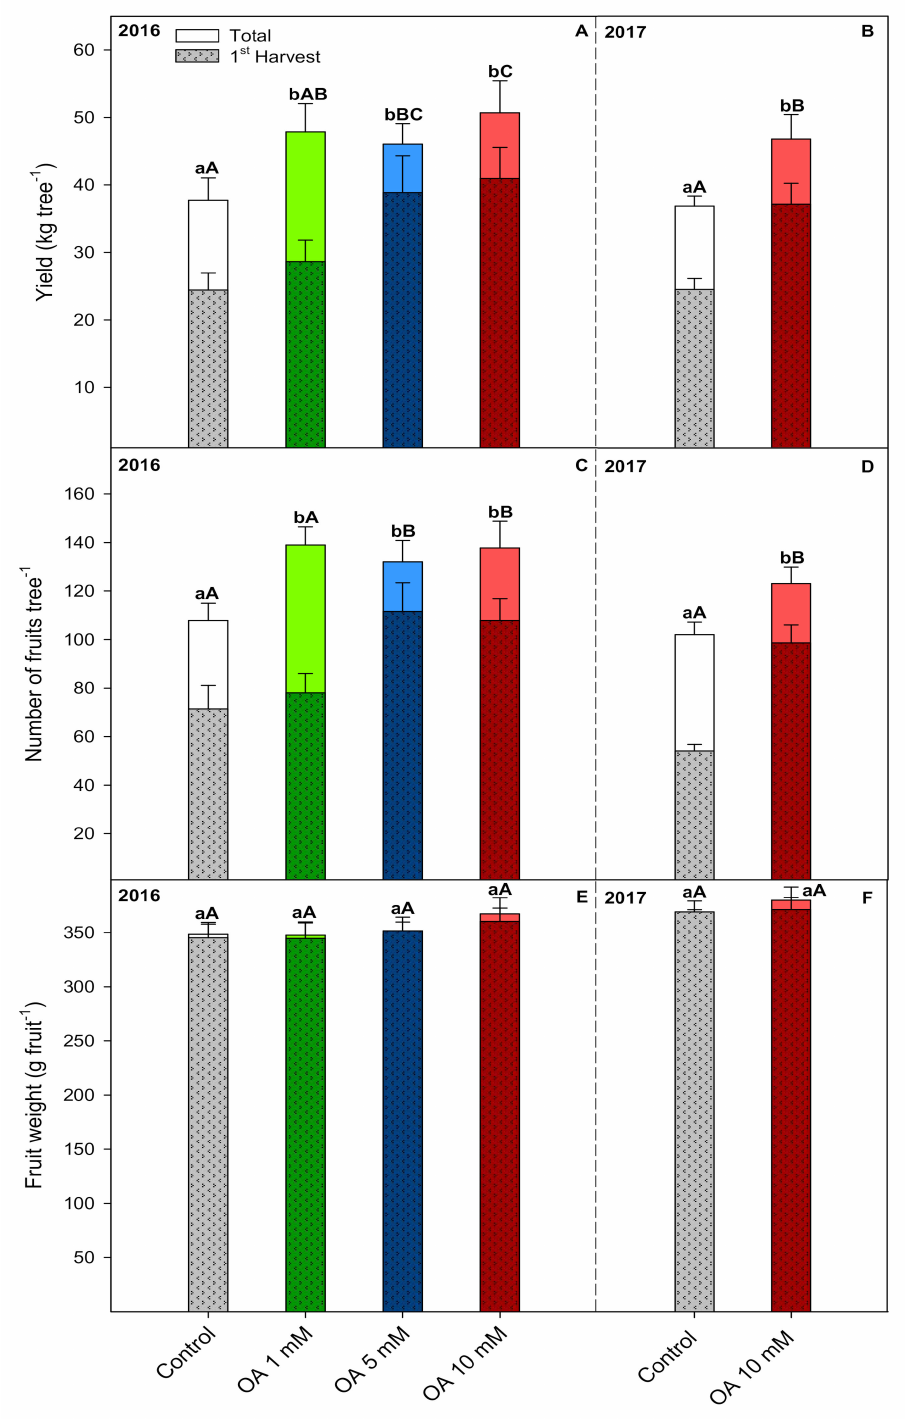
Figure 2. E ff ects of oxalic acid (OA) treatments on crop yield (kilograms per tree; A and B ), number of fruits per tree ( C and D ) and fruit weight (grams per fruit; E and F ) at the first harvest date (dotted bars) and at total harvest (open bars) for 2016 and 2017 years. Data are the mean ± SE. Di ff erent lowercase letters show significant di ff erences among treatments for total yield values and di ff erent capital letters show significant di ff erences for results of the first harvest date at p <